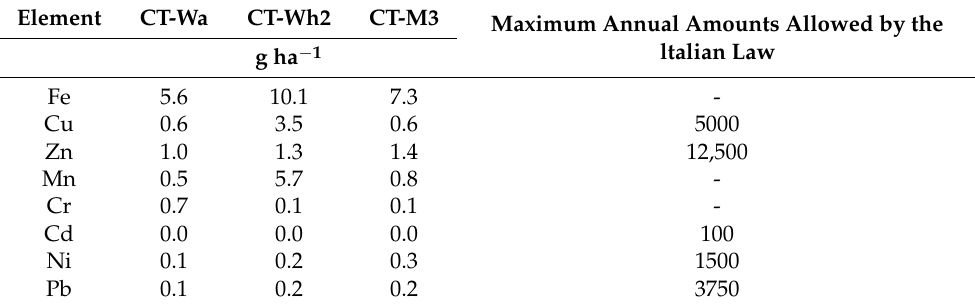
Table 9. Total heavy metals applicable to the soil in the medium period (10 years) by means of